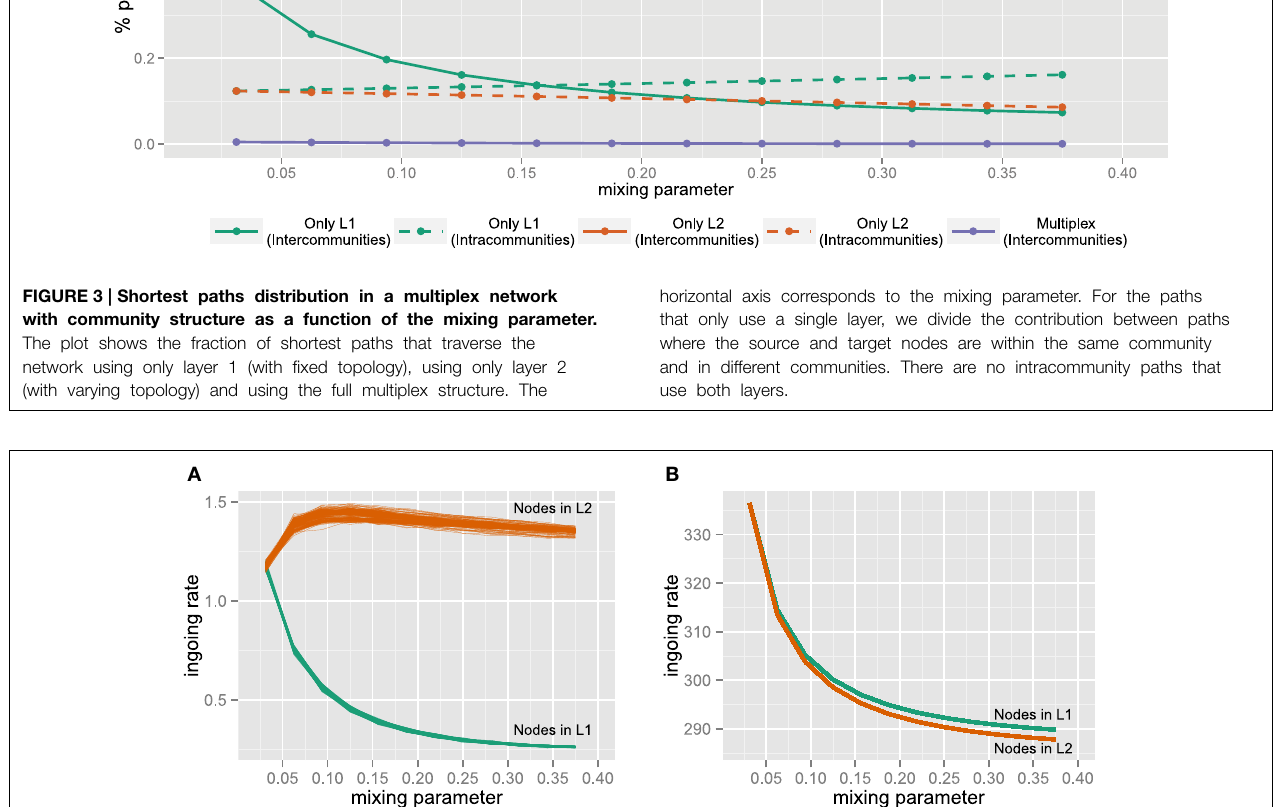
FIGURE 4 | Ingoing rate of each node in the network for different mixing parameter values, and two routing strategies: shortest paths (A) and random walks (B). The different colors indicate the layer to which the node belongs to.